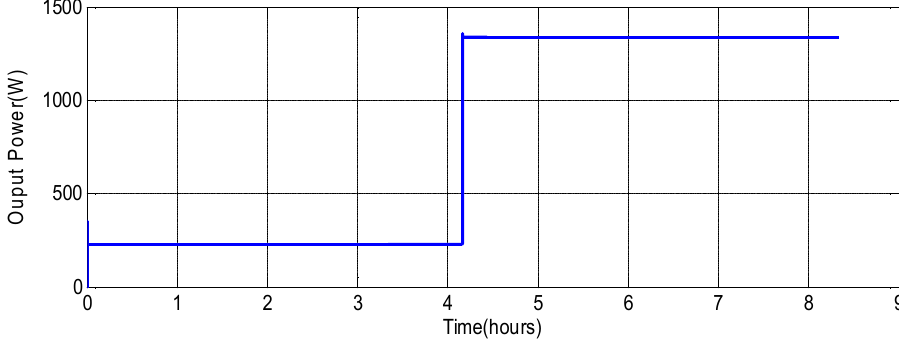
Figure 16. Power vs. time to variable duty cycle.